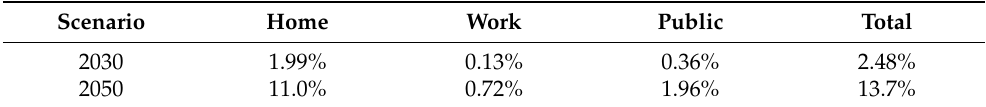
Table 3. Contribution to the peak load.